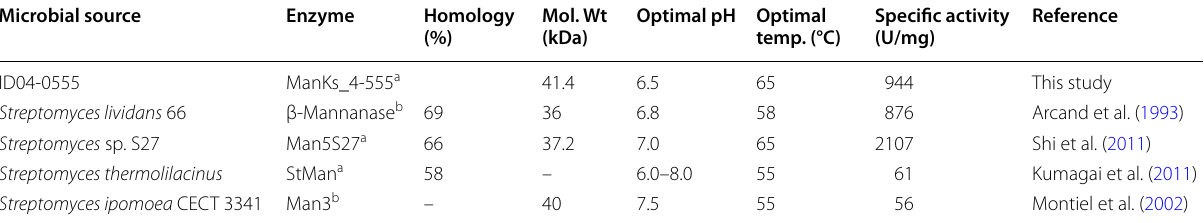
Table 3 Homology analysis and enzyme properties of ManKs_4-555 compared with other Streptomyces β-mannanases Microbial source